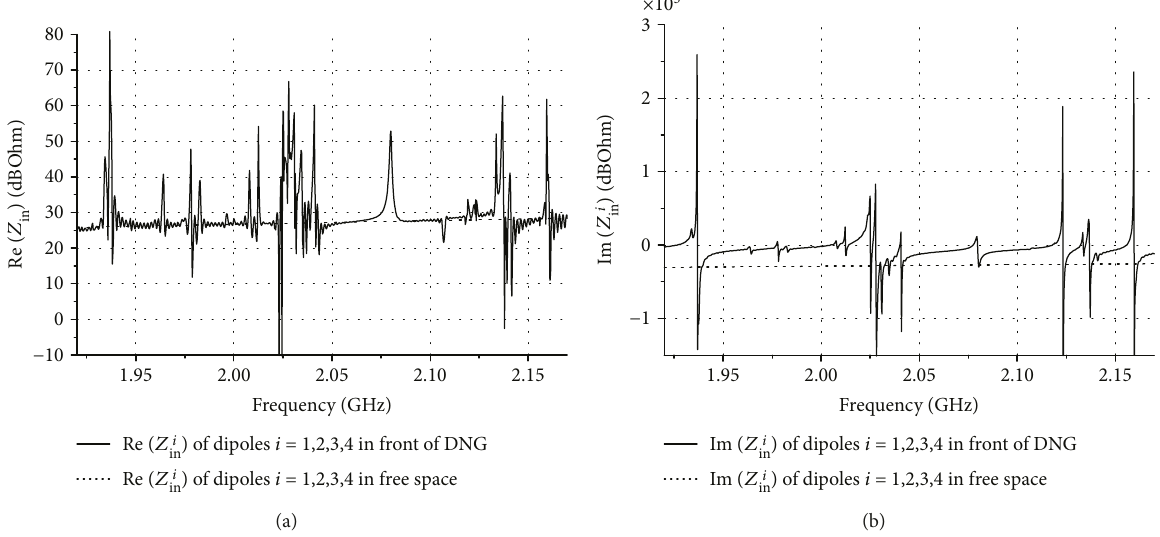
Figure 11: Input impedance of dipoles 1 to 4 with and without DNG slab. (a) Real part. (b) Imaginary part.